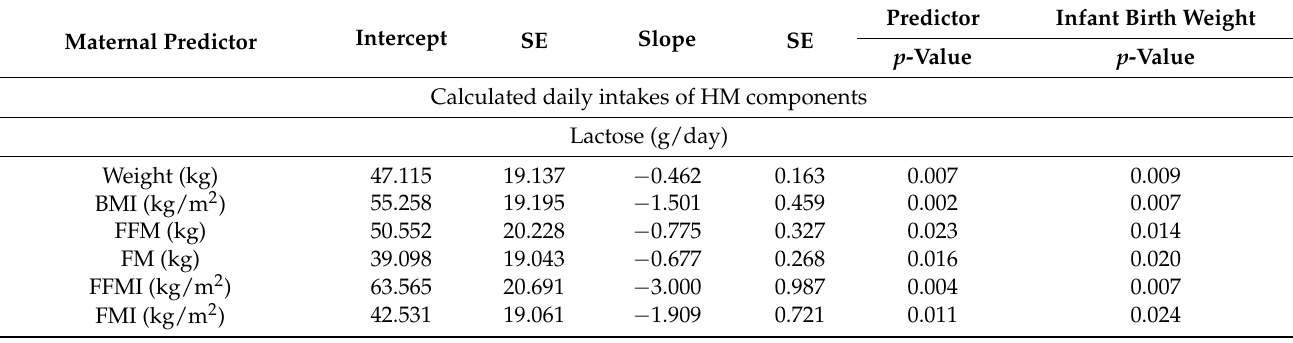
Table 4. Associations between human milk components, 24-h milk intakes and maternal characteristics at 3 months